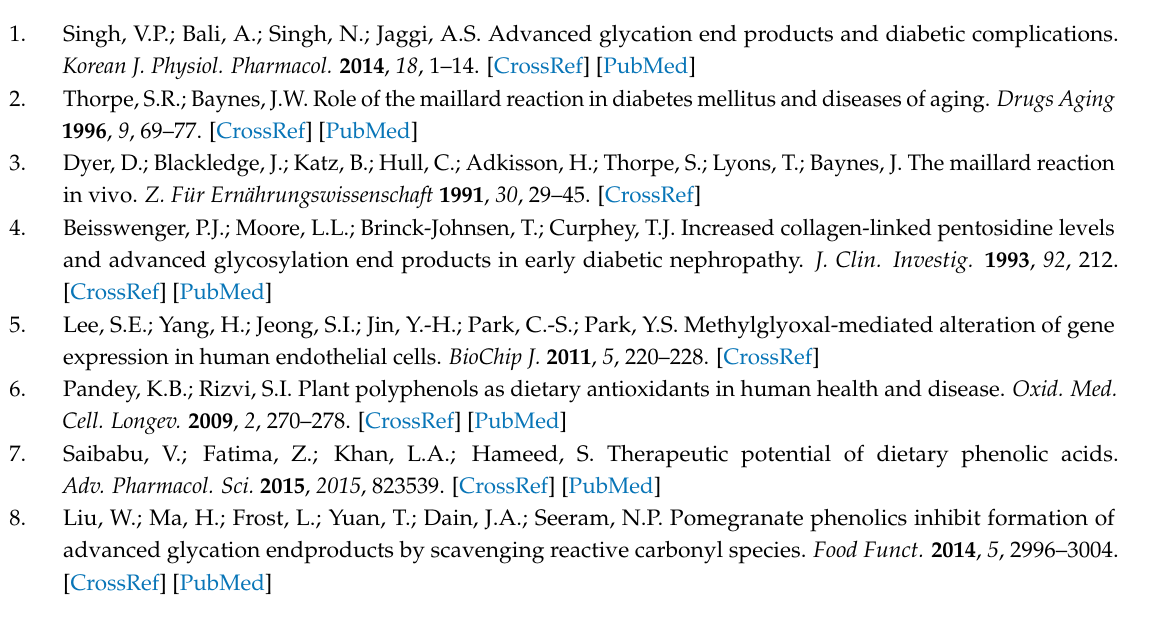
Figure S1: UHPLC–MS/MS chromatogram of a standard mixture of 12 phenolic compounds (2 mg/L), Figure S2. phenolic compounds in peanuts obtained from Yecheon, Table S2: Contents of phenolic compounds in peanuts obtained from Hongcheon, Table S3: Contents of phenolic compounds in peanuts obtained from Kimcheon, Table S4: Contents of phenolic compounds in peanuts obtained from Udo Island. Acknowledgments: This study was carried out with the support of “R&D Program for Forest Science